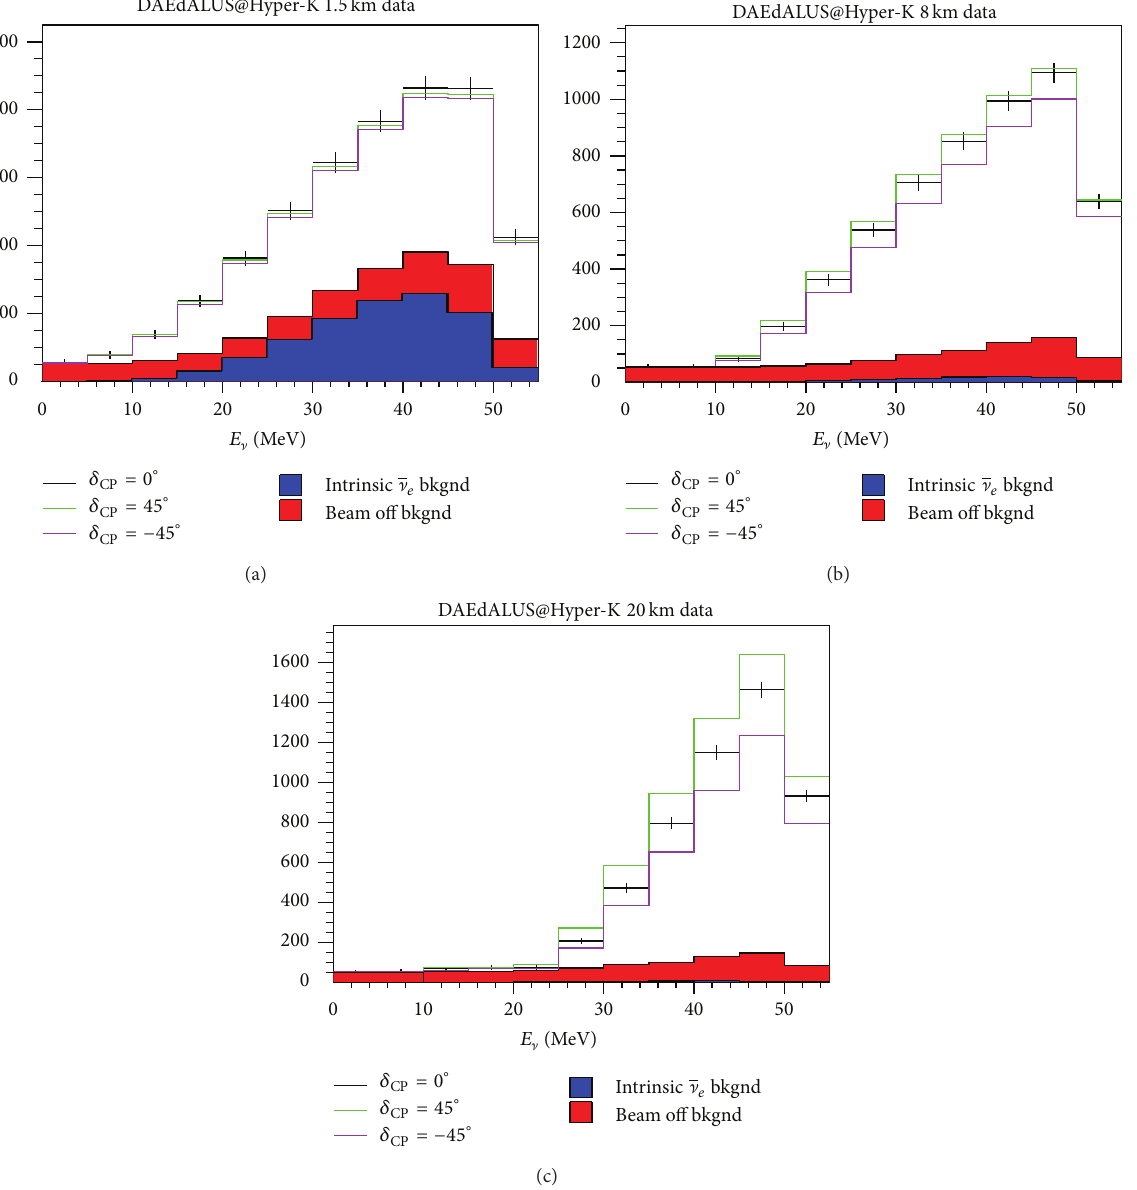
Figure 14: The event energy distributions for signal and background of the DAE 𝛿 ALUS@Hyper-K running scenario with sin 2 2𝜃 13 = 0.10 . = 0 , 45 ∘ and −45 ∘ . The blue histogram shows the intrinsic ] Black, green, and violet histograms show signals for 𝛿 𝑒 beam-on background. CP The red histogram shows the beam-off backgrounds. (a) and (b) show events from the near (1.5km) and middle (8km) accelerators. (c) shows events from the far (20km)